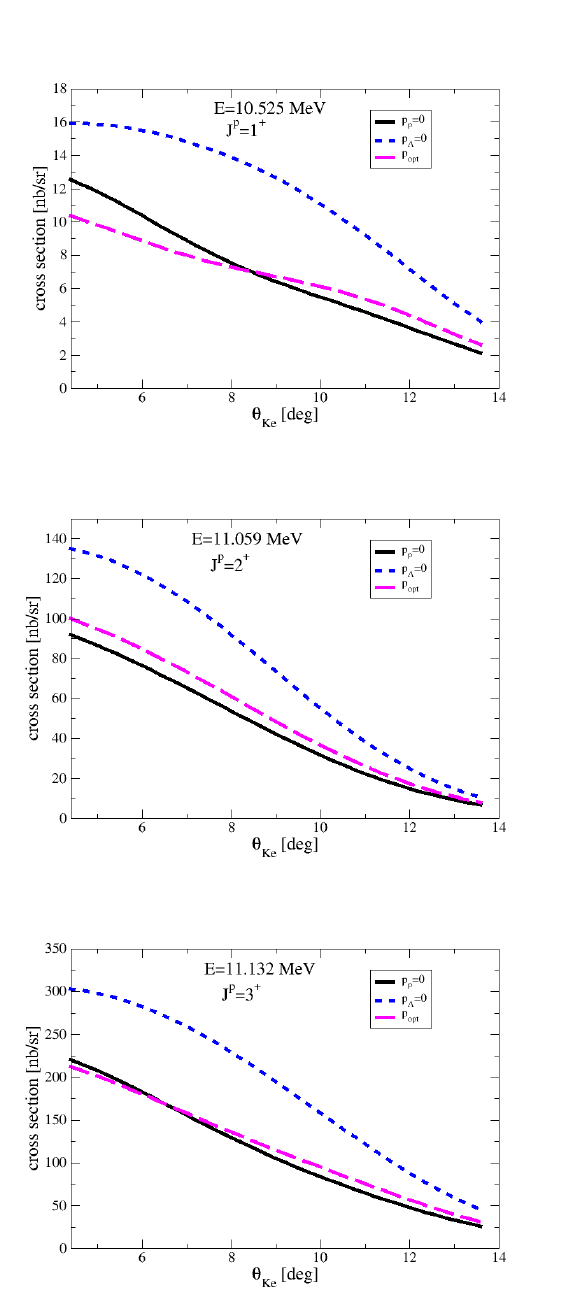
Figure 1. Angular dependence of the electroproduction cross sections induced by virtual photons for three excited states of 12 Λ B with the energy E and spin-parity J p